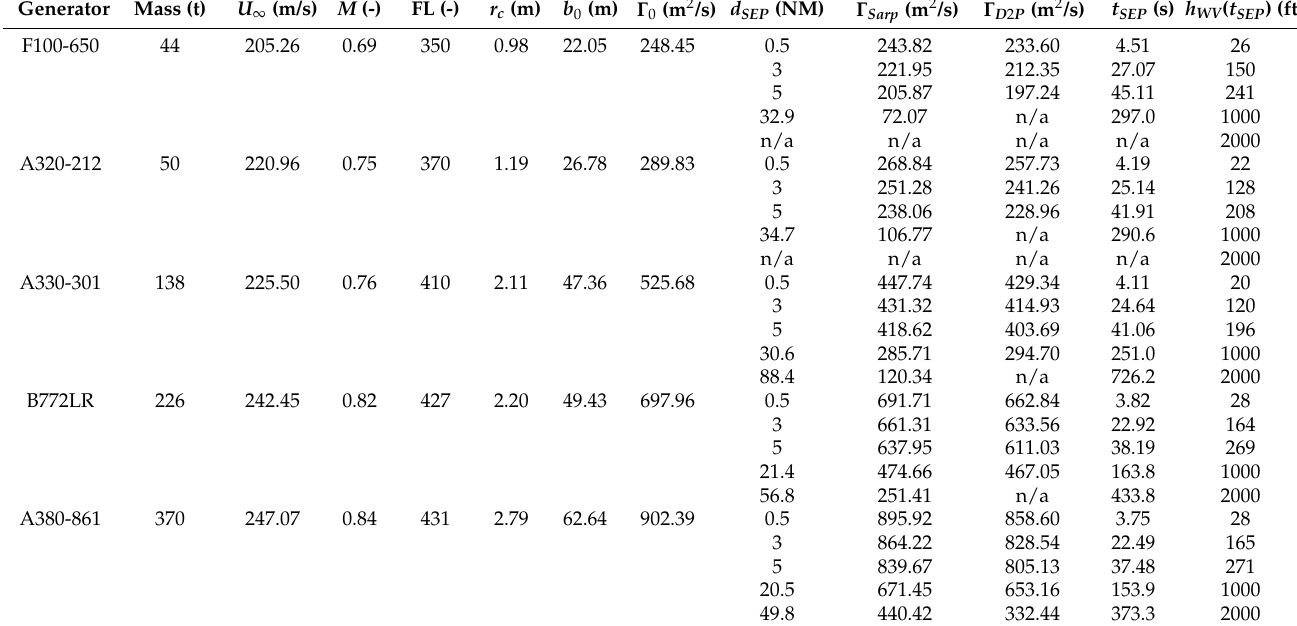
Table 1. Maximum circulations of the wake vortex generated by several aircraft and flight conditions of the generator. Generator Mass